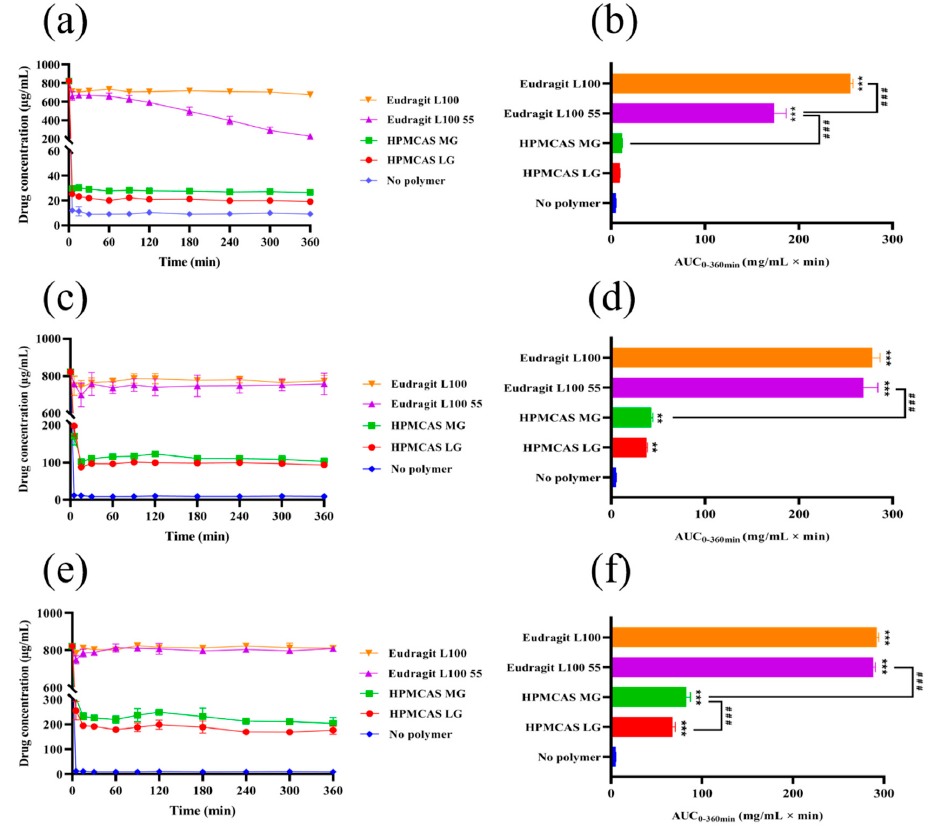
Figure 4. Supersaturation kinetics of nintedanib and AUC 0–360min in pH 6.8 PBS buffer with different polymers. ( a , b ) 0.1%; ( c , d ) 0.5%; ( e , f ) 1% ( w / v ). Data are expressed as the mean ± SD ( n = 3). ** p < 0.01, *** p < 0.001 significantly compared to the no polymer group, ### p < 0.001.